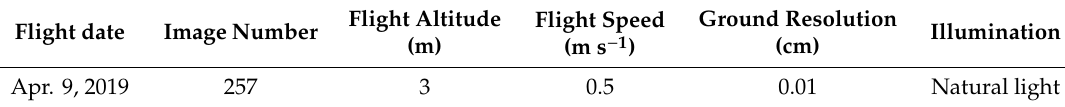
Table 2. Experimental unmanned aerial vehicle (UAV) flight